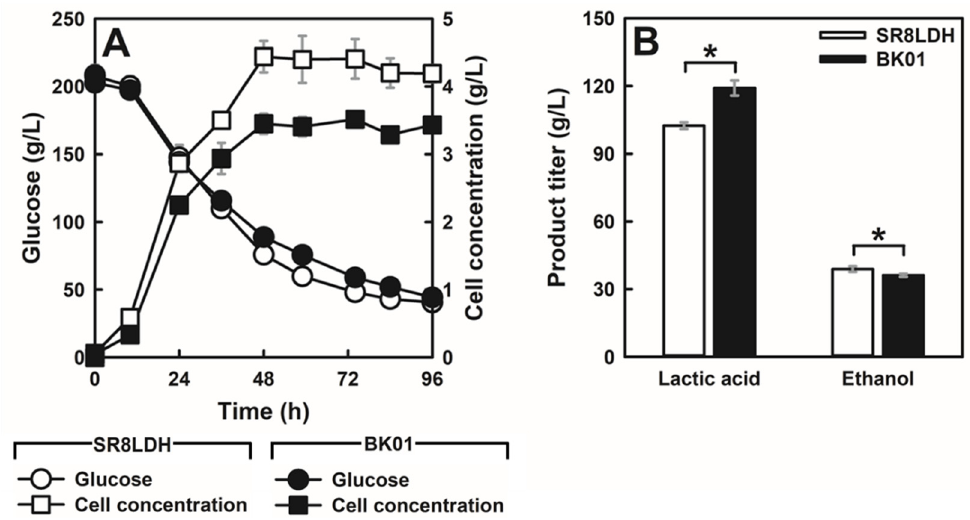
Figure 3. Comparison of lactic acid production by SR8LDH and BK01 in a high concentration of glucose. ( A ) Glucose (circle) and cell concentrations (square). ( B ) Lactic acid and ethanol titers for 96 hours of fermentation. The values represent the mean of three independent experiments. The error bars indicate standard deviation. Asterisks denote statistically significant differences (Student’s t -test, p < 0.05). Fermentations were performed using complex medium containing 200 g/L glucose, under oxygen-limited conditions (80 rpm), with an initial cell concentration of 0.05 g DCW/L. Table 2. Comparison of engineered S. cerevisiae strains producing lactic acid.